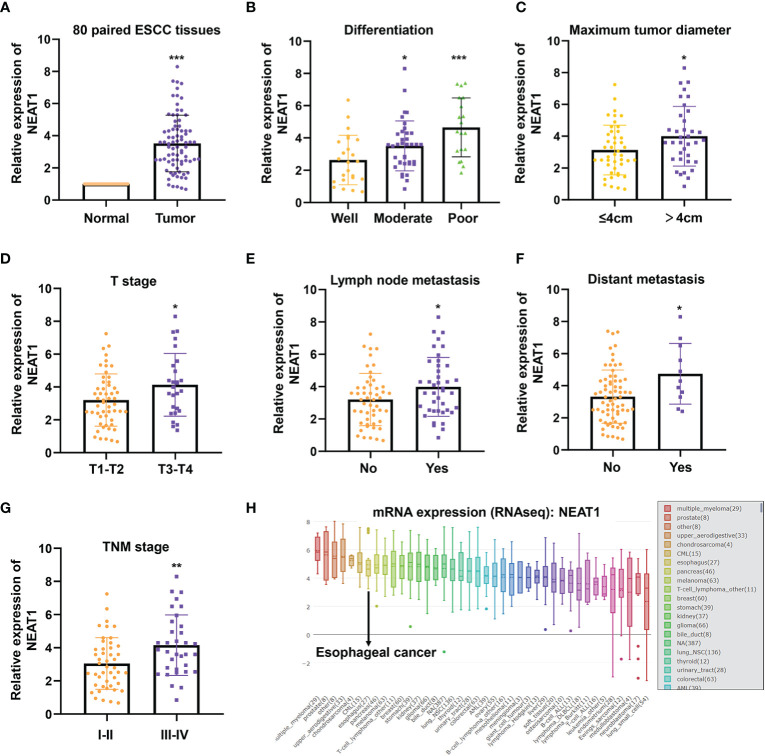
NEAT1 was up-regulated in ESCC and correlated with clinical features. (A) The expression of NEAT1 in 80 paired ESCC tissues was detected by qRT-PCR and results indicated that NEAT1 was significantly upregulated in ESCC tissues compared with adjacent normal tissues (p < 0.001). (B) Tumor tissues of moderate and poor differentiation bore higher expression of NEAT1 relative to those of well differentiation (p < 0.05; p < 0.001). (C) NEAT1 was more highly expressed in tumor tissues with larger size (p < 0.05). (D) The upregulaticlinicalon of NEAT1 correlated with more advanced T stages of patients (p < 0.05). (E, F). Patients with lymph node or distant metastasis exerted higher expression of NEAT1 (p < 0.05; p < 0.05). (G) NEAT1 showed higher expression in patients with later TNM stage (p < 0.01). (H) The mRNA levels of NEAT1 in different cancer cell lines were presented by CCLE. *P < 0.05, **P < 0.01, ***P < 0.001, n.s., no significance.